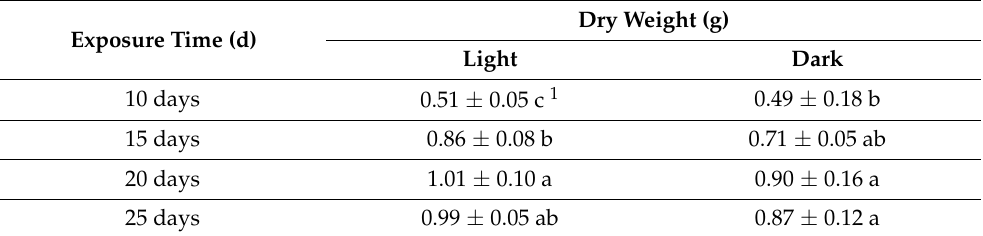
Figure 1. P. frutescens microgreens grown under long-day photoperiod or continuous darkness conditions. ( A ) Microgreens grown for 10 days under dark condition ( left ) and microgreens grown for 10 days under long-day photoperiod condition ( right ); ( B ) microgreens grown for 15 days under dark condition ( left ) and microgreens grown for 15 days under long-day photoperiod condition ( right ); ( C ) microgreens grown for 20 days under dark condition ( left ) and microgreens grown for 20 days under long-day photoperiod condition ( right ); and ( D ) microgreens grown for 25 days under dark condition ( left ) and microgreens grown for 25 days under long-day photoperiod condition ( right ). Table 1. The effect of light and dark treatment on dry weight of P . frutescens microgreens.